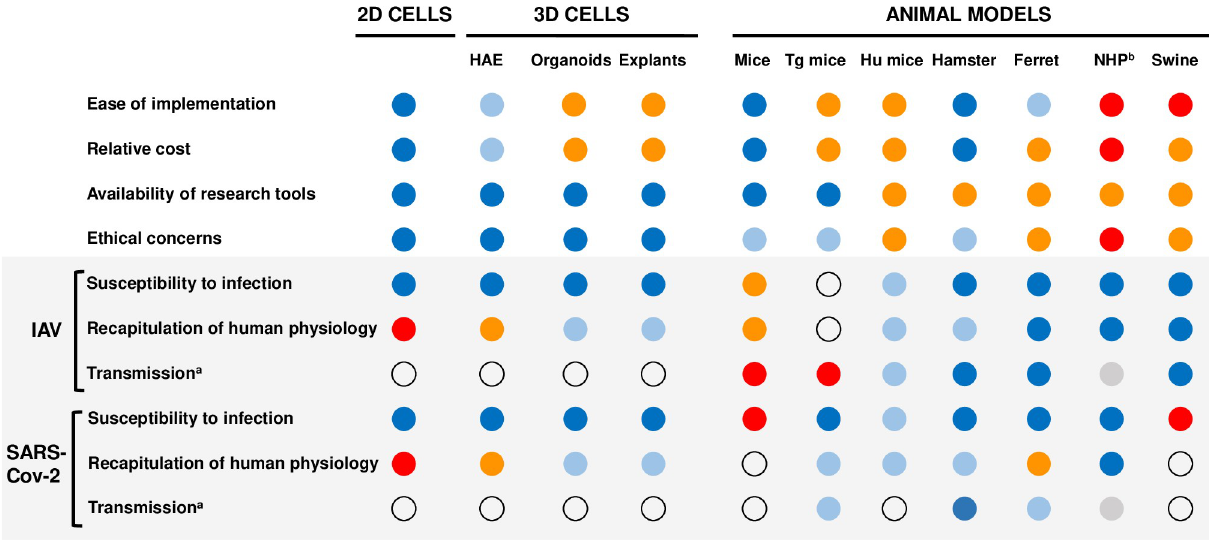
Fig 3. Cellular and animal models available for IAV and SARS-CoV-2 infections [174–176]. An estimation of the performance to the criteria indicated on the left is provided with the following color code: dark blue (very good), light blue (good), orange (poor), red (very poor), gray (not documented), no color (irrelevant). a All transmission routes including aerosol and direct contact routes. b NHP have been very rarely used in transmission studies; however, it was reported that H1N1pdm09 influenza viruses can efficiently transmit between marmosets [177]. 2D/3D, two- or three-dimensional; HAE, human airway epithelium; Hu mice, humanized mice (refers to mice grafted with human immune cells in the case of IAV and to mice grafted with human lung tissue in the case of SARS-CoV-2); IAV, influenza A virus; NHP, nonhuman primate; SARS-CoV-2, Severe Acute Respiratory Syndrome Coronavirus 2; Tg mice, transgenic